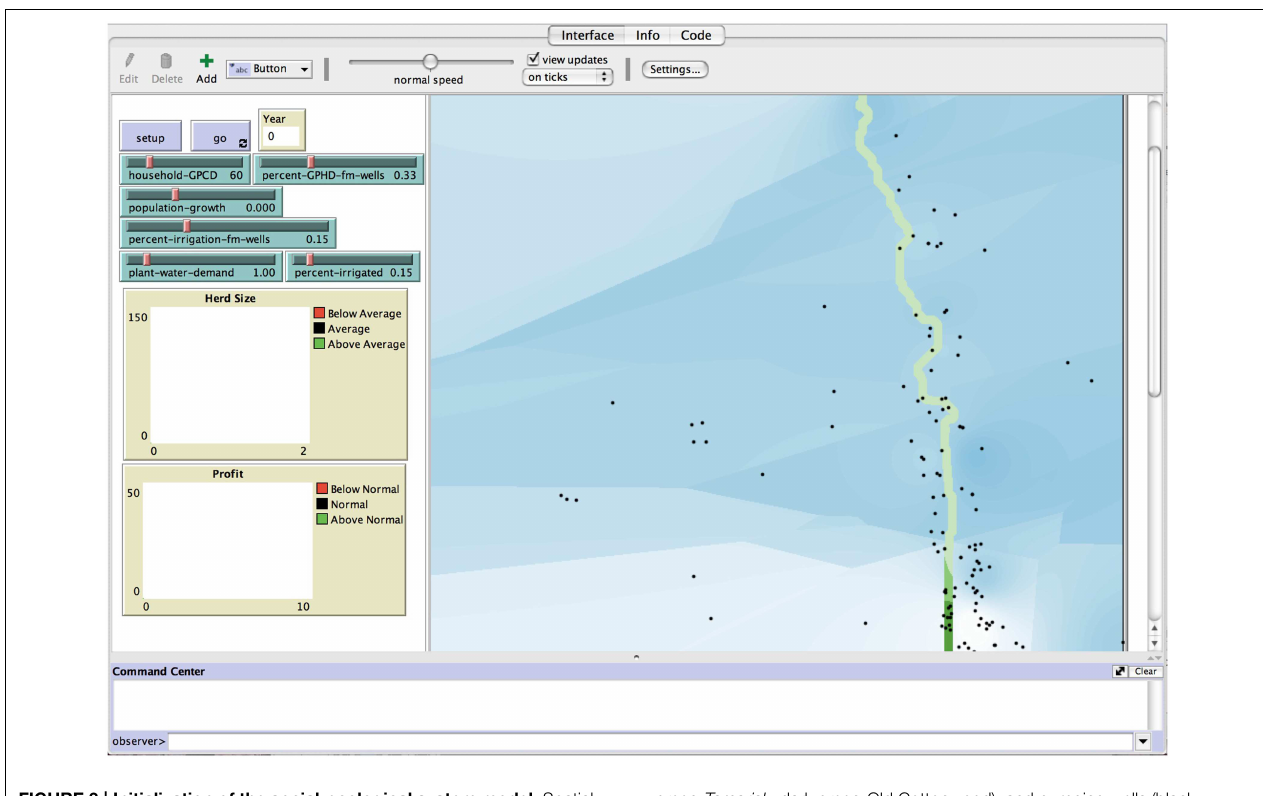
green- Tamarisk , dark green-Old Cottonwood), and pumping wells (black circles). Sliders bar present potential scenarios for stakeholder exploration of the